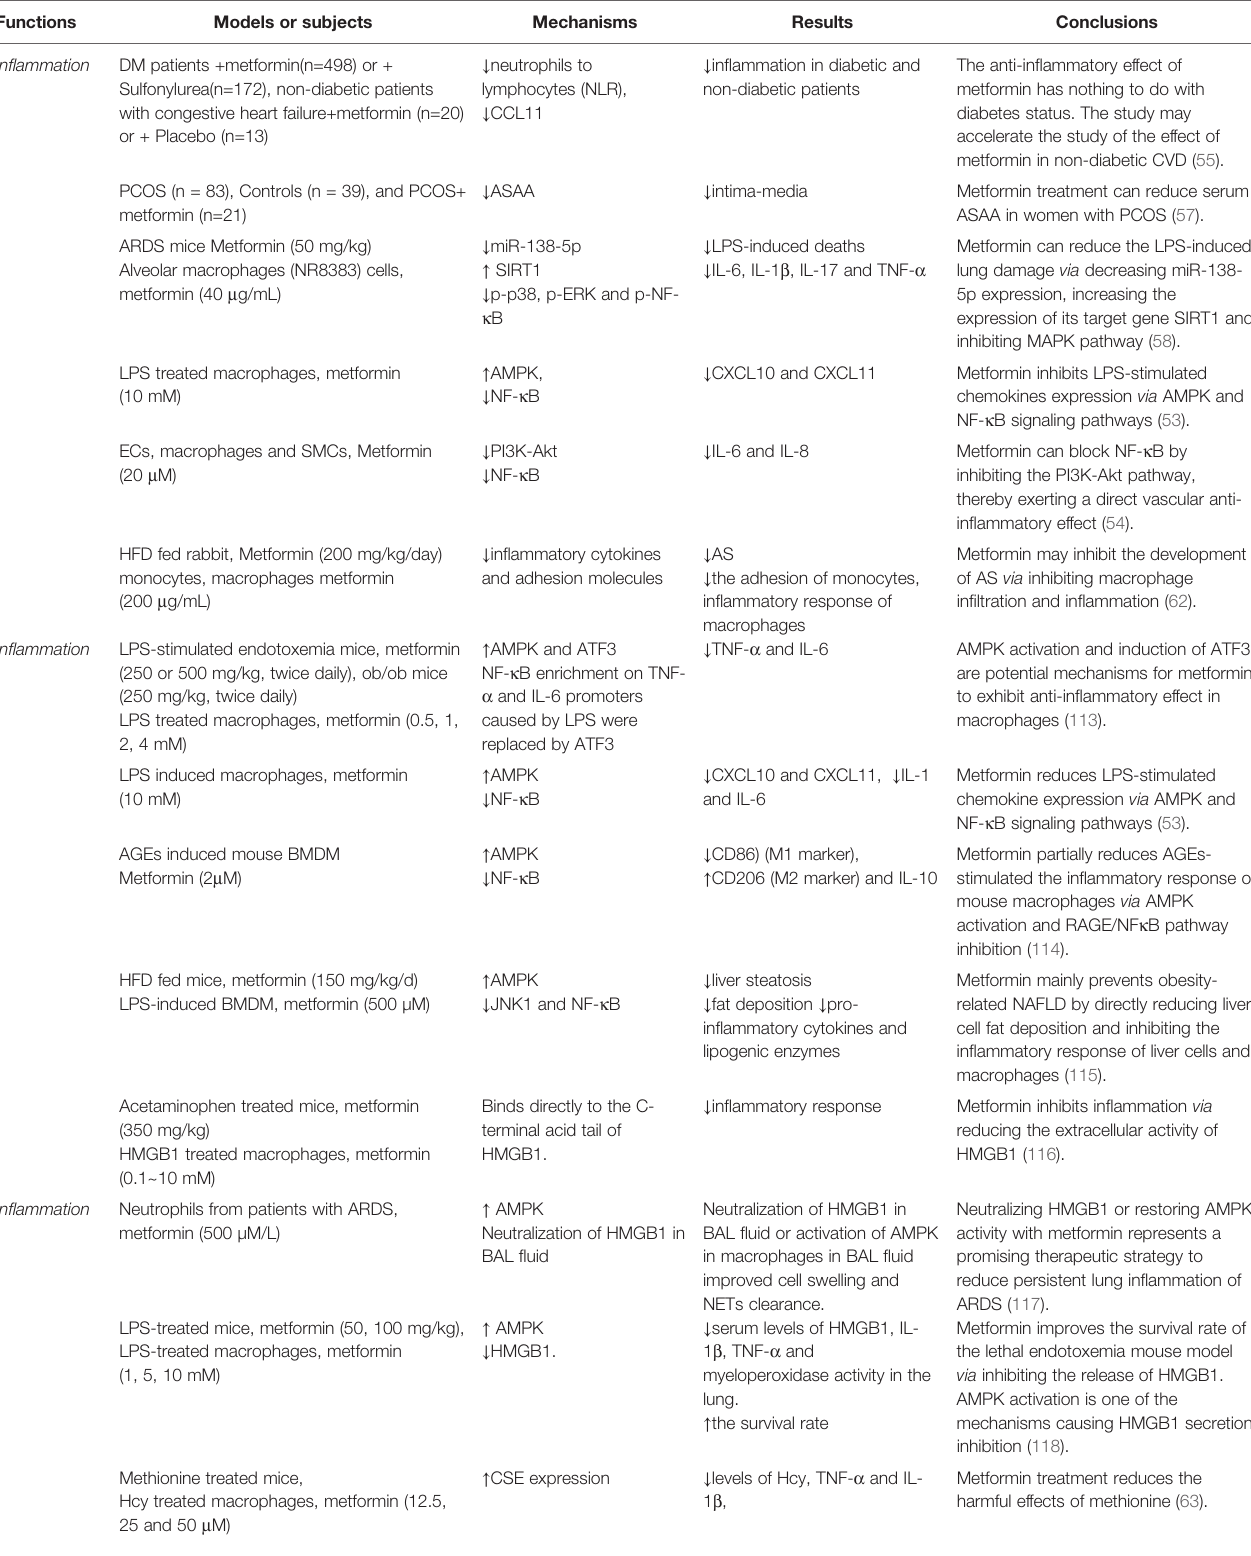
TABLE 2 | Clinical, animal and cellular studies of metformin on macrophages associated with atherosclerotic diseases.